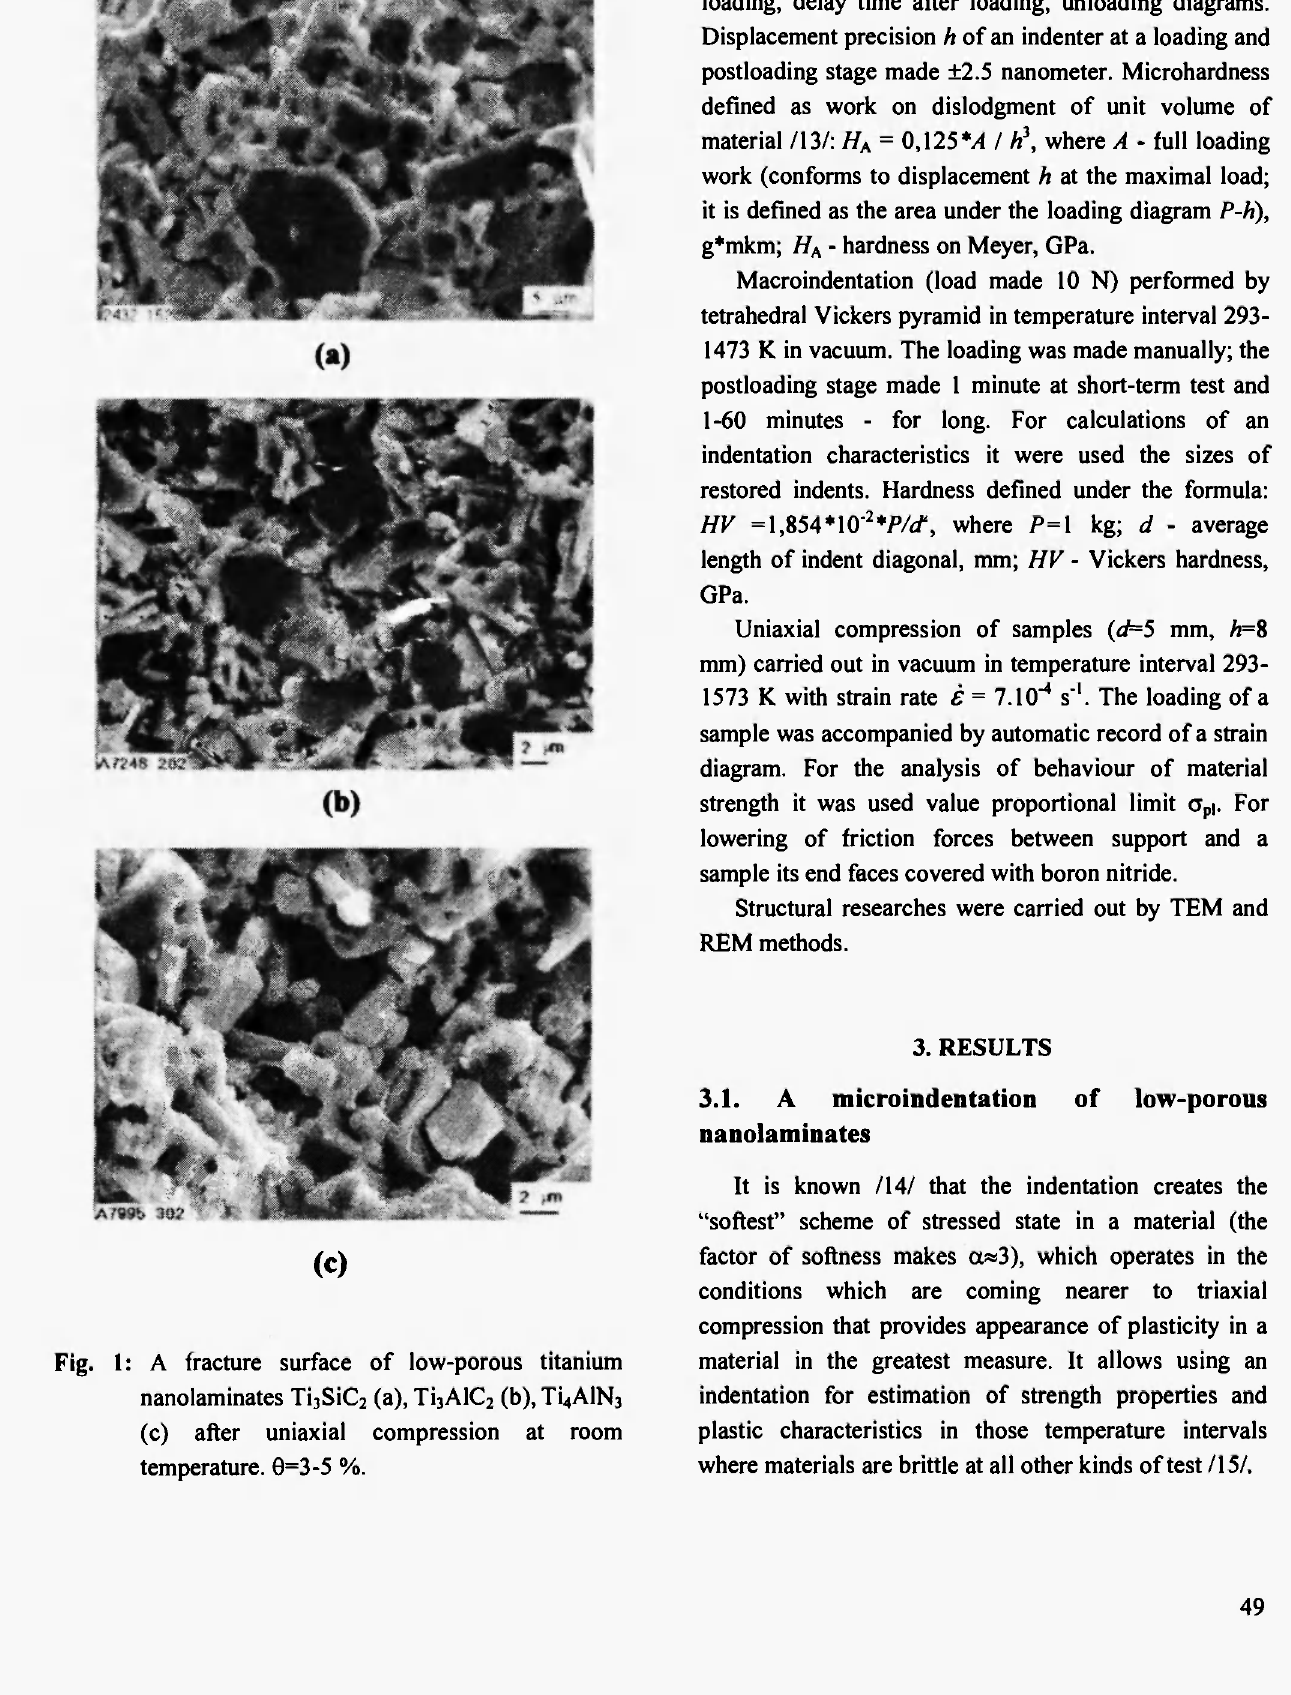
Fig. I: A fracture surface of low-porous titanium nanolaminates Ti 3 SiC 2 (a), Ti 3 AlC 2 (b), Ti 4 AlN 3 (c) after uniaxial compression at room temperature. 0=3-5